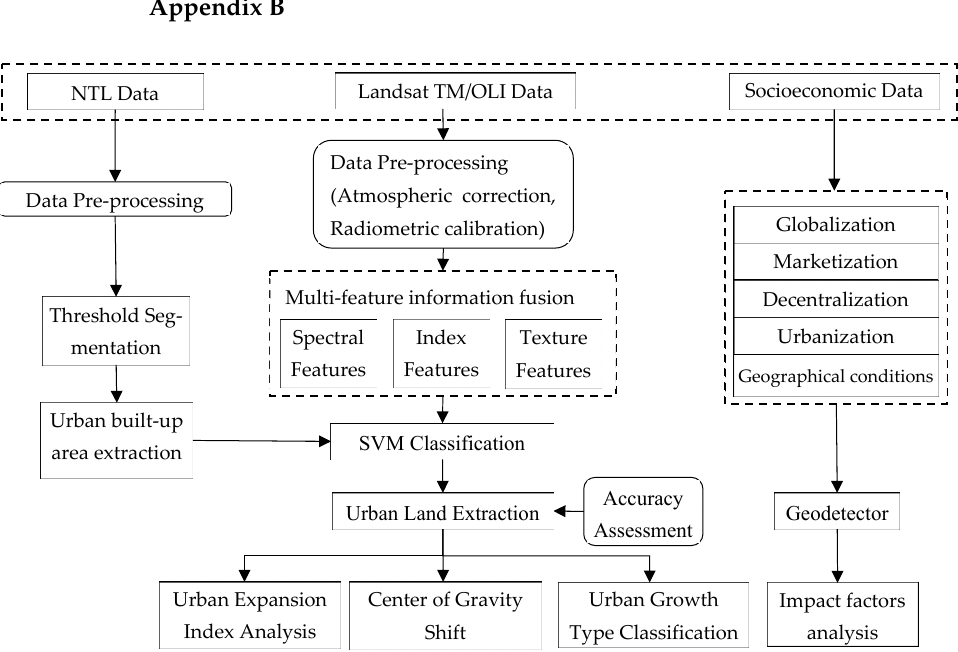
Figure A1. Flowchart for revealing Nanchang’s urban expansion and its impact factors.